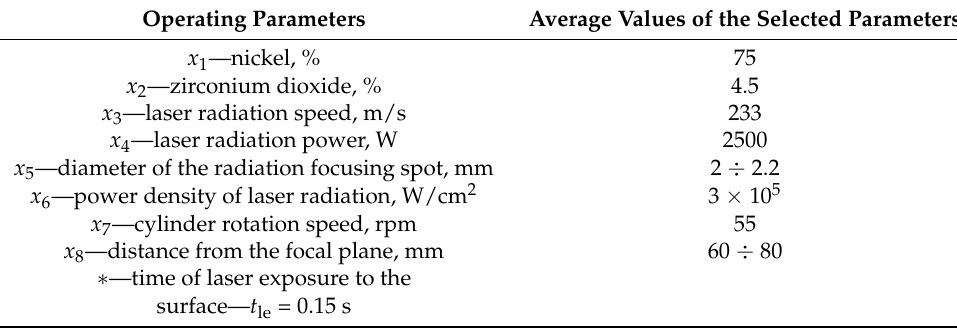
Table 2. Variable mode parameters during the welding laser overlay experiment. Operating Parameters Average Values of the Selected